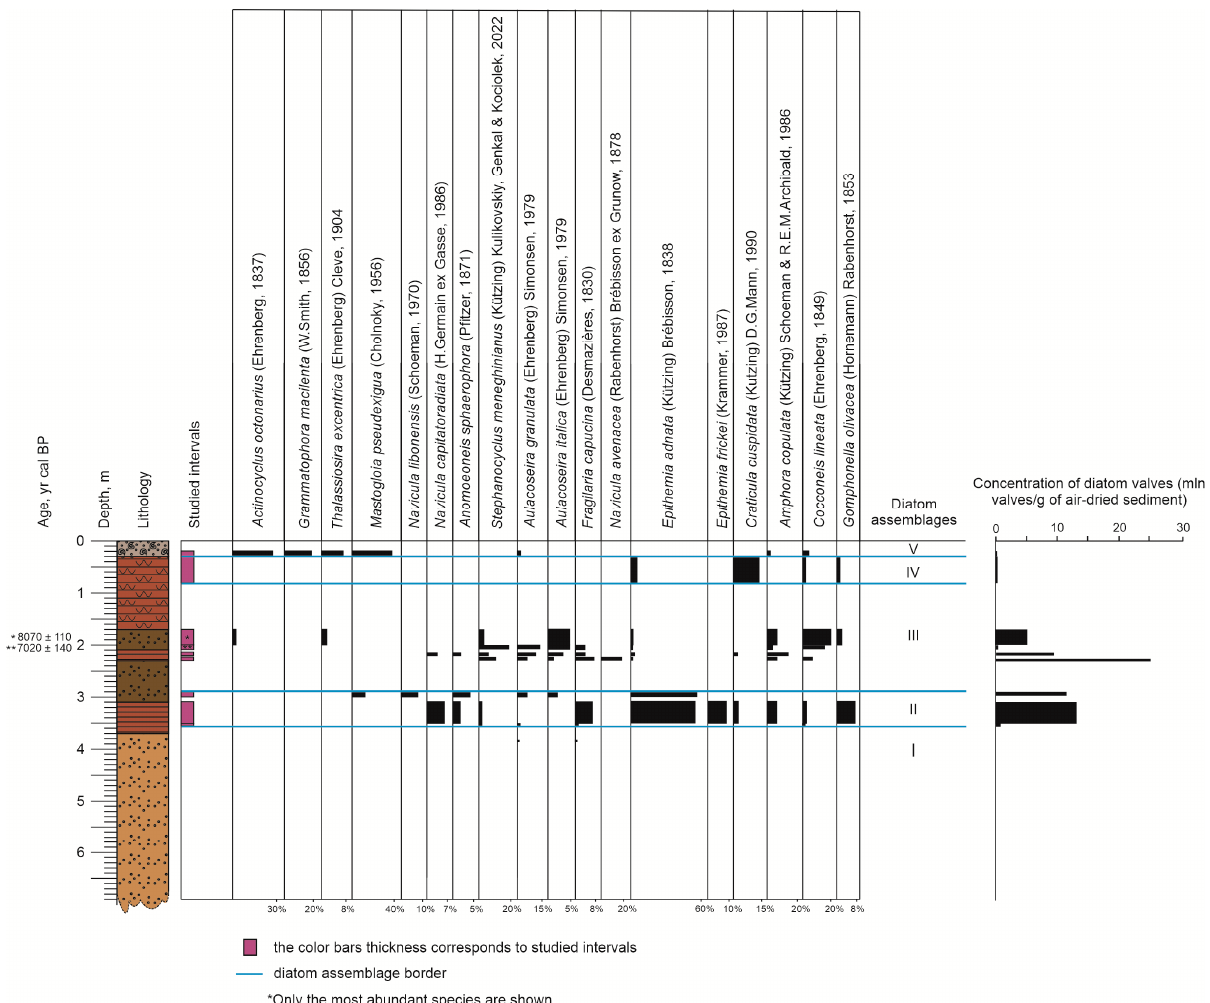
Figure 6. Rybachya core list of diatoms (grouped from left to right from marine/brackish water to freshwater species).